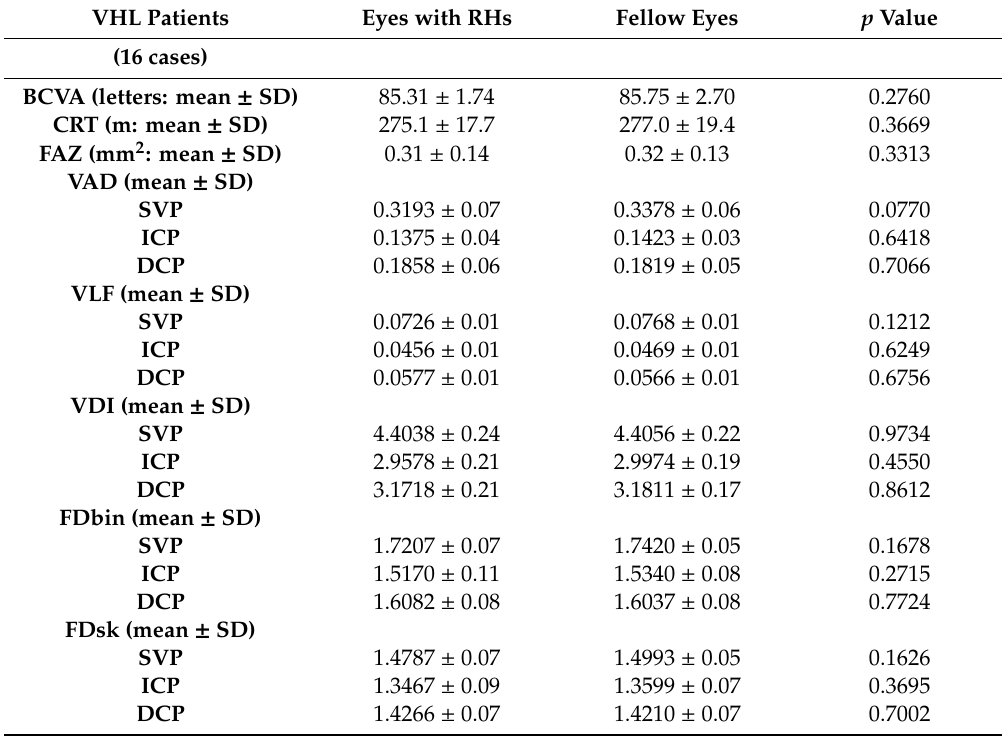
Table 4. OCT and OCTA parameters in VHL patients with monocular lesions (eyes with RHs versus fellow eyes with no